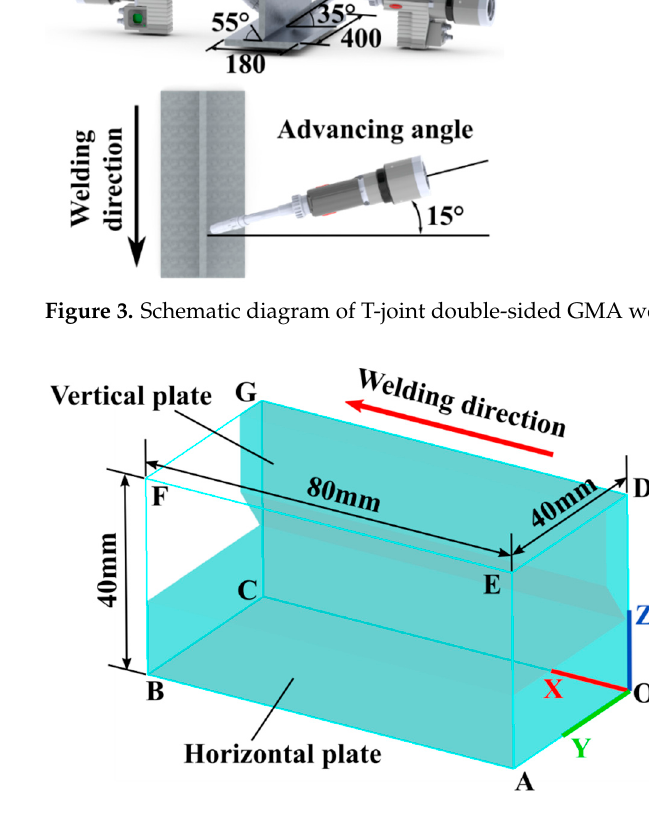
Figure 4. Computational domain.